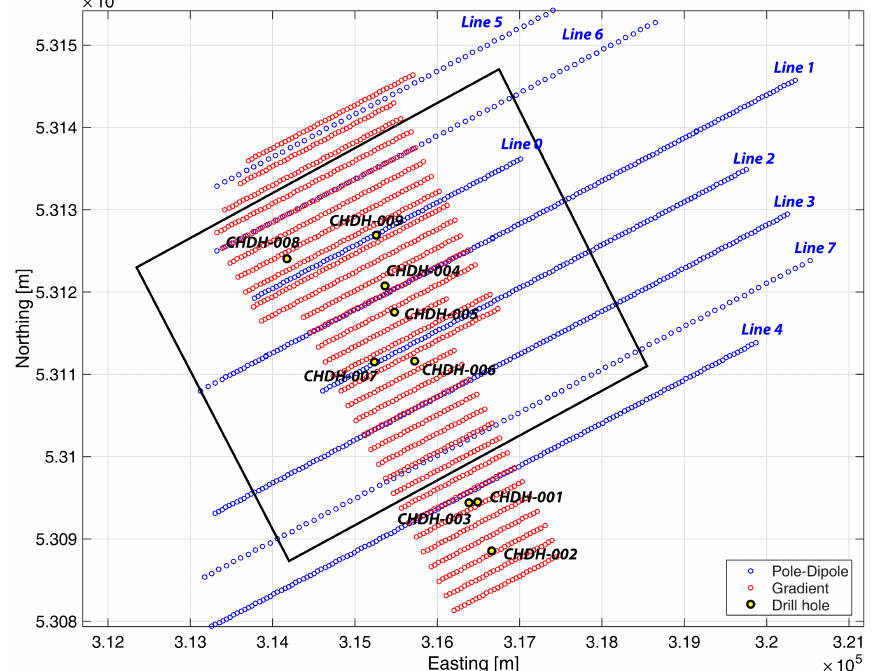
Figure 6. IP survey lines (pole–dipole and gradient arrays) in the survey area. The black rectangle shows the area with higher potential of mineralization, estimated from drilling